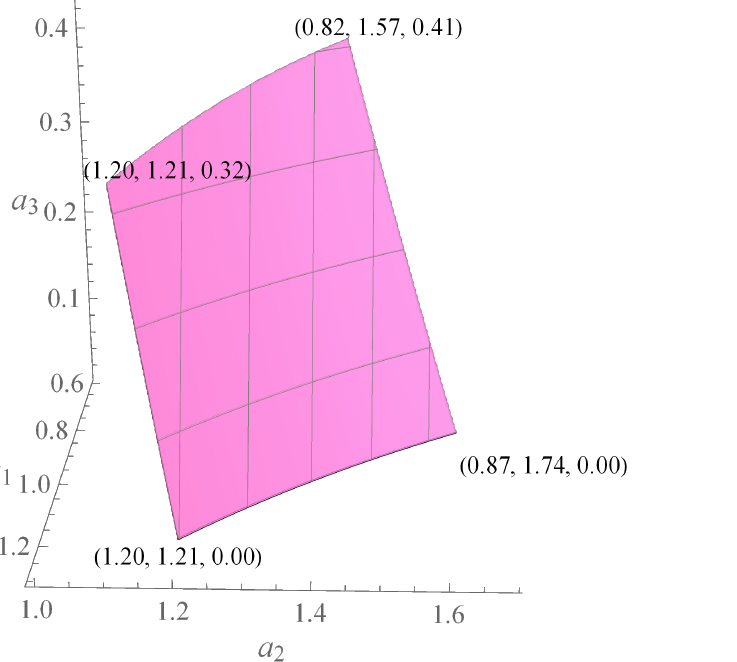
Figure 1 : “Viable” region of Kähler moduli space that satisfies all constraints in section 2 for the line bundle L = O (2 , 1 , 3) X